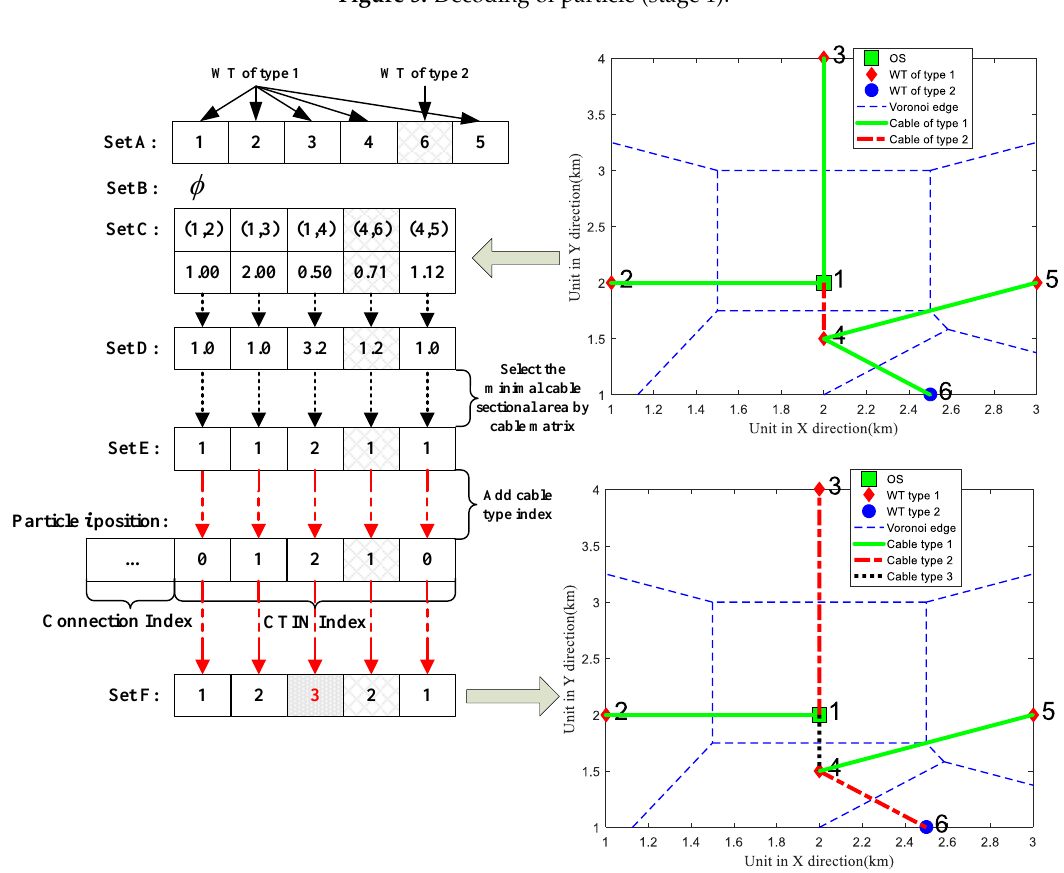
Figure 6. Decoding of particle (stage 2).